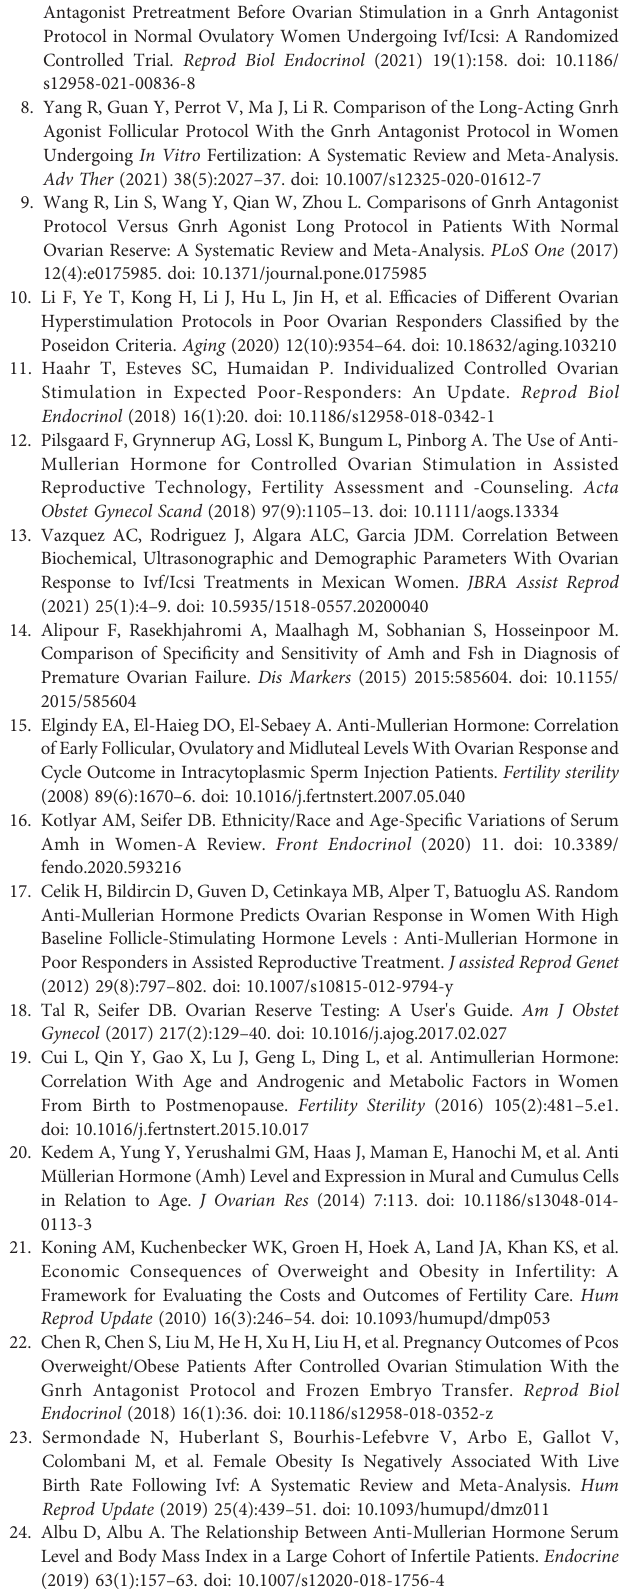
Protocol in Normal Ovulatory Women Undergoing Ivf/Icsi: A Randomized Controlled Trial. Reprod Biol Endocrinol (2021) 19(1):158. doi: